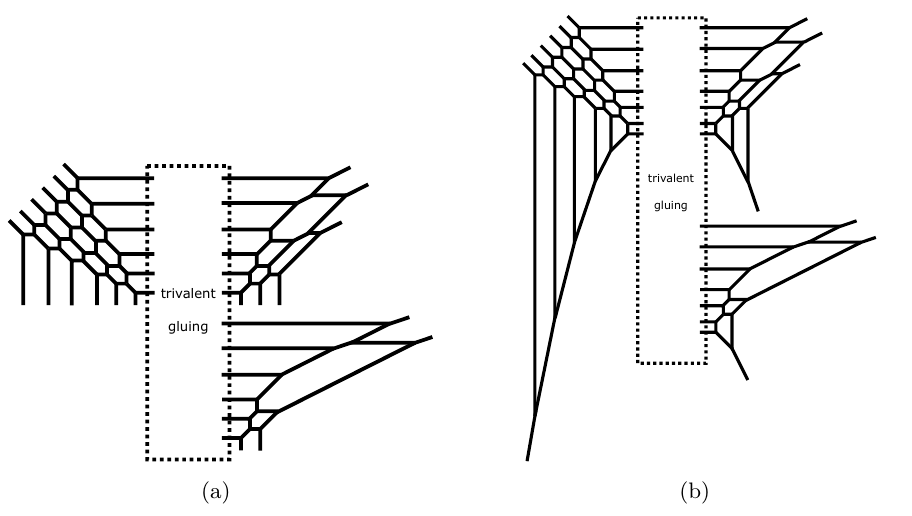
Figure 54. (a): The web diagram for the theory (A.1) or (A.2). (b): The web diagram for the theory